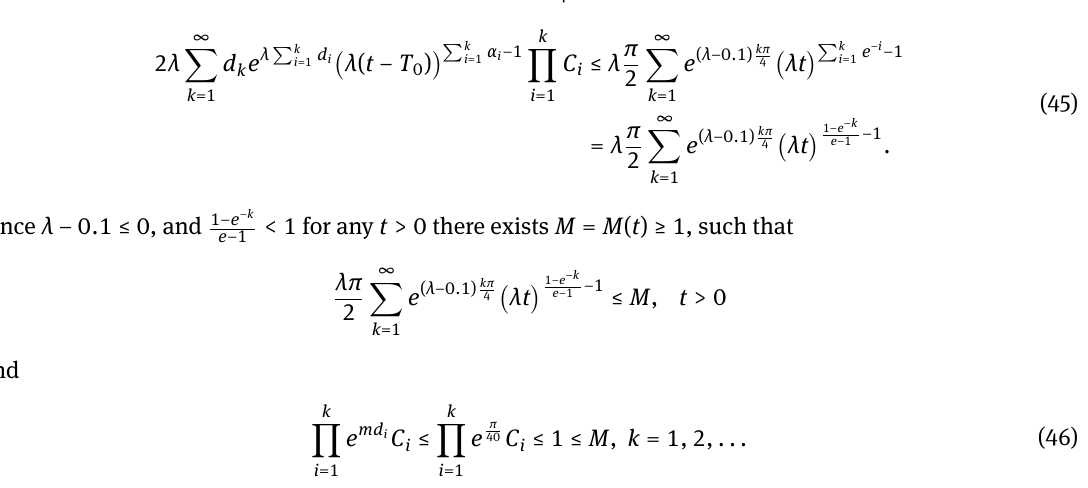
, m = 0.1 and T 0 = 0. 4